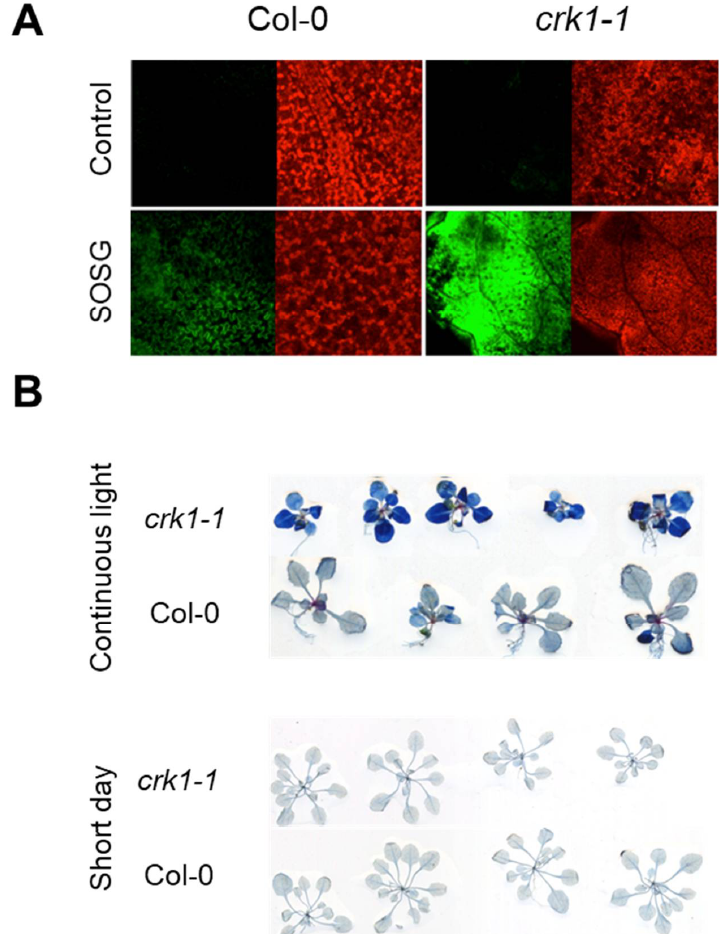
Figure 8. Reactive oxygen species (ROS) accumulation and cell death in At crk1-1 mutant. ( A ) 1 O 2 production in leaves of At crk1-1 mutant detected by fluorescence of the Singlet Oxygen Sensor Green (SOSG) probe. Plants were infiltrated with SOSG and exposed to high light (10 µM SOSG, 2300 µmole photons m − 2 s − 1 for 5 min). Fluorescence was detected by confocal laser scanning microscopy (CLSM). Note intensive fluorescence of SOSG-infiltrated mutant leaves; ( B ) Cell death in Arabidopsis sp. leaves, detected by Evans blue staining. 3-week old plants were grown either on short day or under continuous light. Note intensive Evans blue reaction in At crk1-1 mutants when exposed to continuous light.